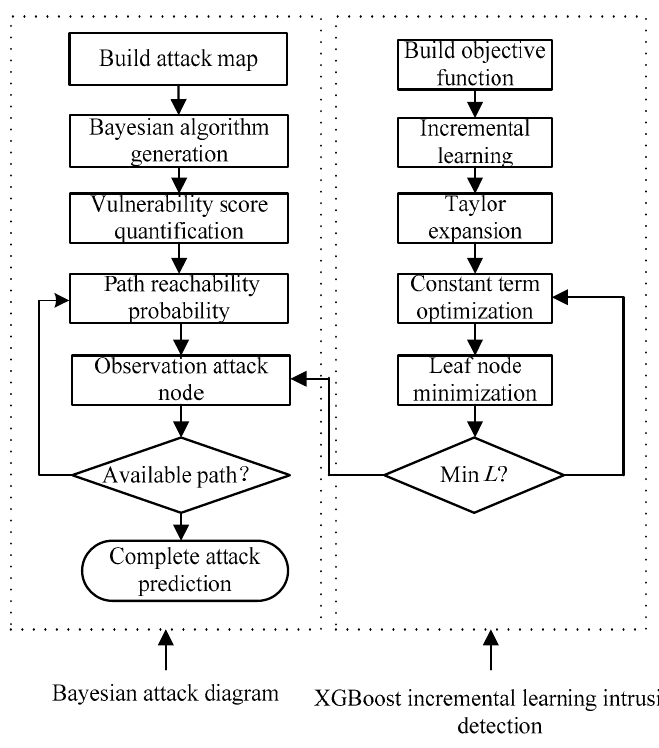
Figure 3. Network Intrusion Detection Process Based on Bayesian Attack Graph and